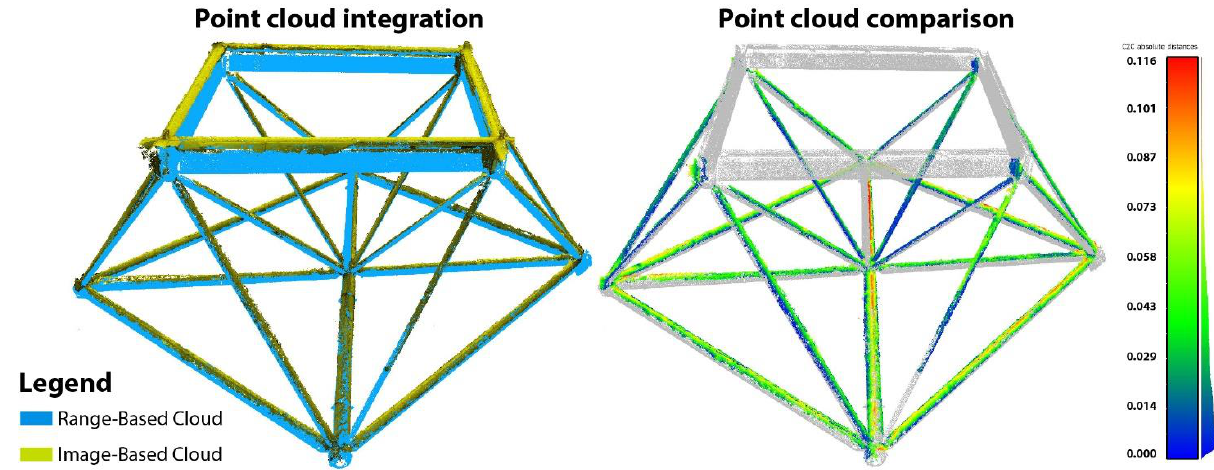
Figure 8: Integration between range-based and image-based point clouds and metric comparison in overlapping